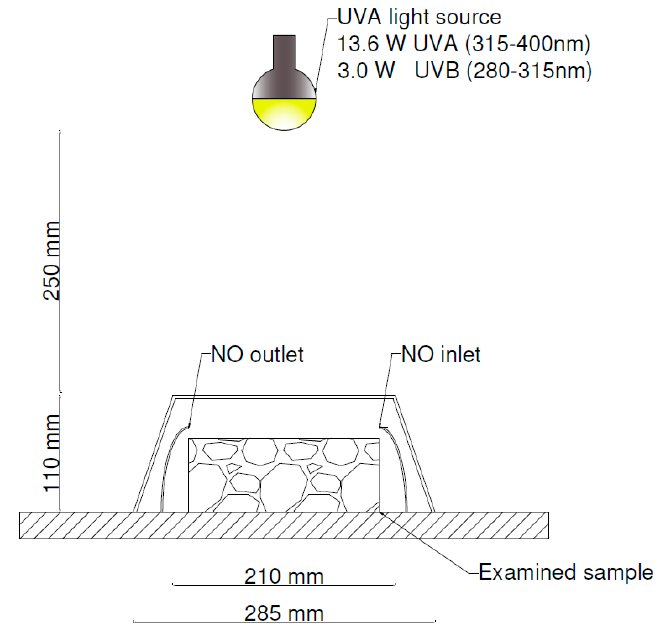
Figure 9. Test setup for laboratory conditions according to Witkowski et al. [29].